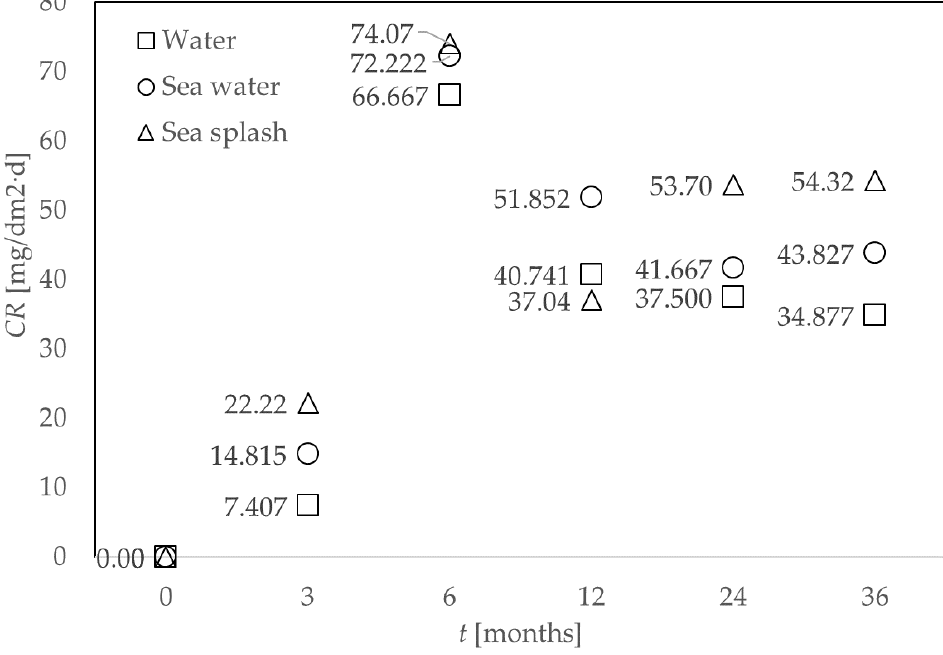
Figure 4. Average corrosion rate ( CR ) for AH36 steel specimens exposed over time ( t ) to air, water, seawater, and sea splash for 3, 6, 12, 24, and 36 months.